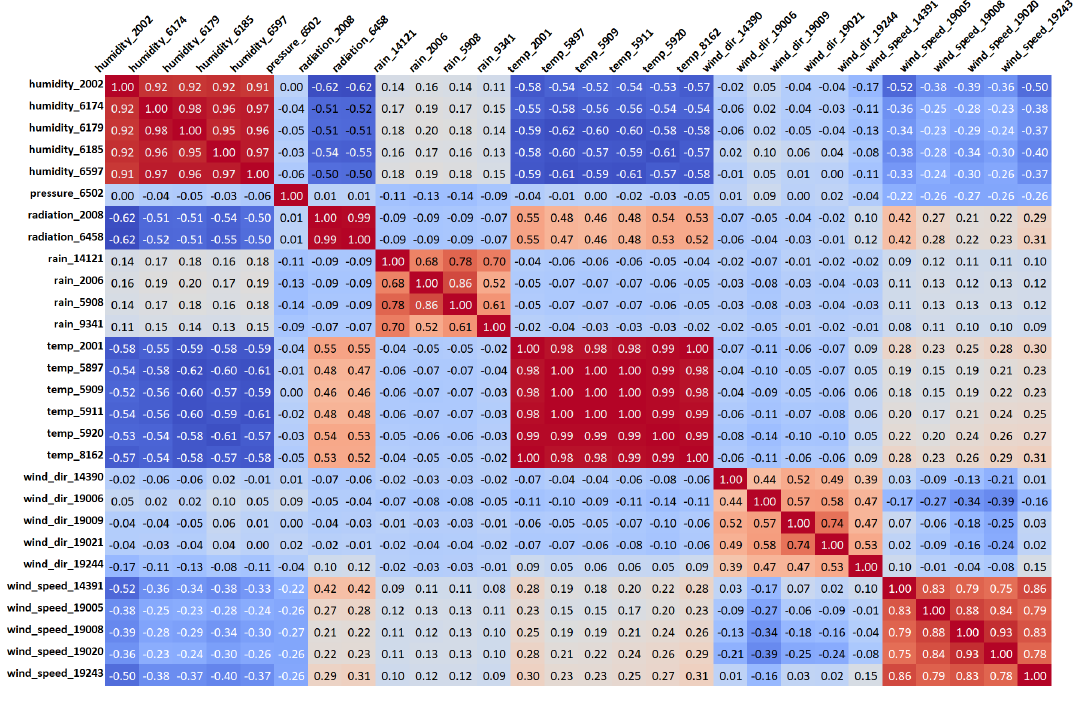
Figure A2. Correlation matrix among unique weather